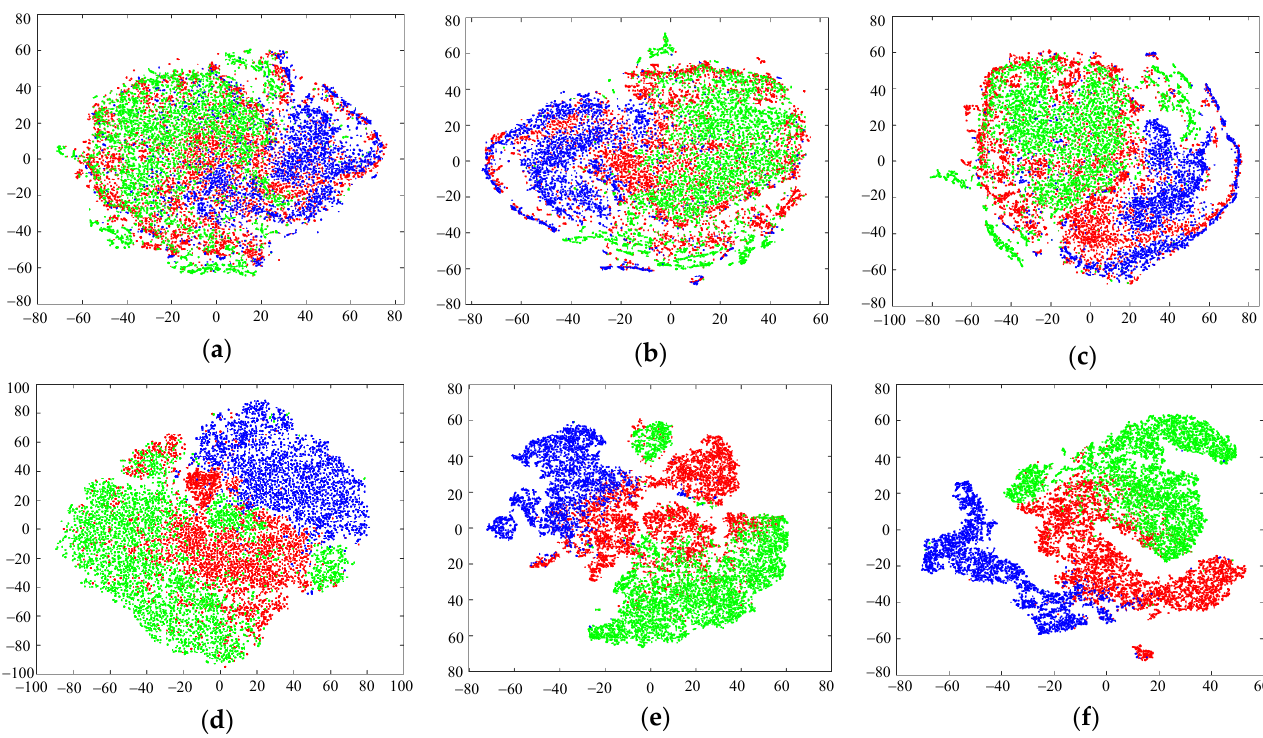
Figure 9. Comparisons of the visualized output features between ( a – c ): original noisy test samples with SNR of 5 dB, 10 dB, 15 dB; and ( d – f ): denoised test samples with SNR of 5 dB, 10 dB, 15 dB.